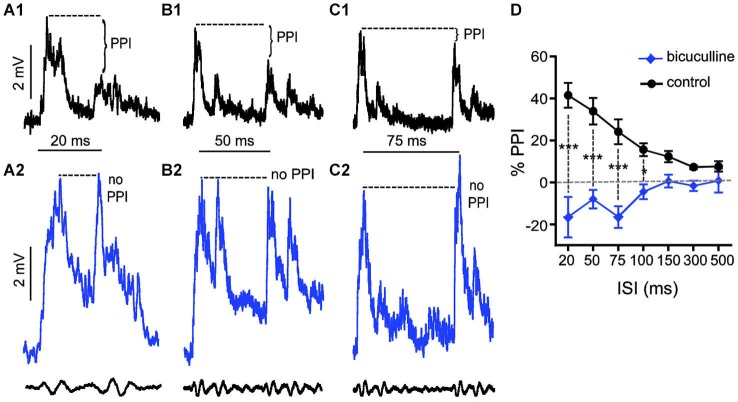
GABAARs mediate peak inhibitory components of PPI. (A–C) Sample intracellular recordings from the Mauthner-cell (M-cell) soma in response to paired (prepulse/pulse) sound pips at ISIs of 20 ms (A1,A2), 50 ms (B1,B2), and 75 ms (C1,C2) in control (black) and after application of the GABAAR antagonist bicuculline (blue). Bottom traces show sound stimuli (200 Hz single-cycle “pips” at 80 dB re: 20 μPa). Dashed lines and brackets indicate how PPI was quantified by comparing peak depolarization between the two evoked post-synaptic potentials (PSPs). (D) Plots of the mean % PPI effect (± SEM, N = 5) across the full range of ISIs tested in control (black line) and bicuculline (blue line) conditions; asterisks indicate an ISI-specific reduction in PPI at ISIs of 20, 50, 75, and 100 ms (see text).